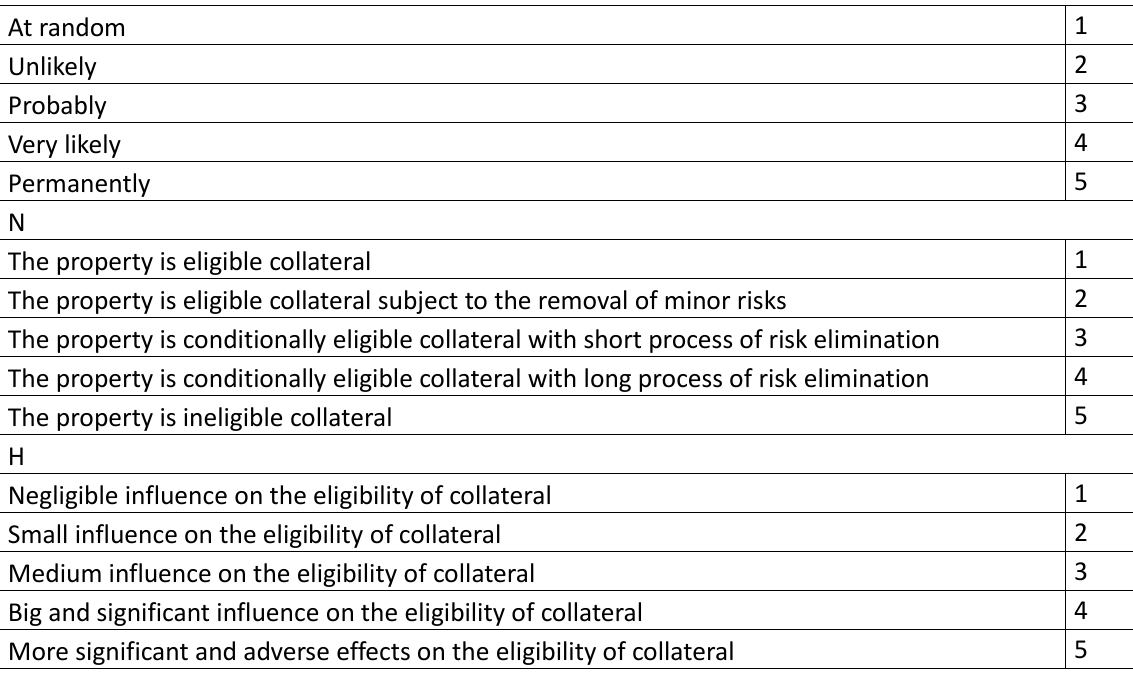
Table 1 - PNH Method estimation scale ([1], own